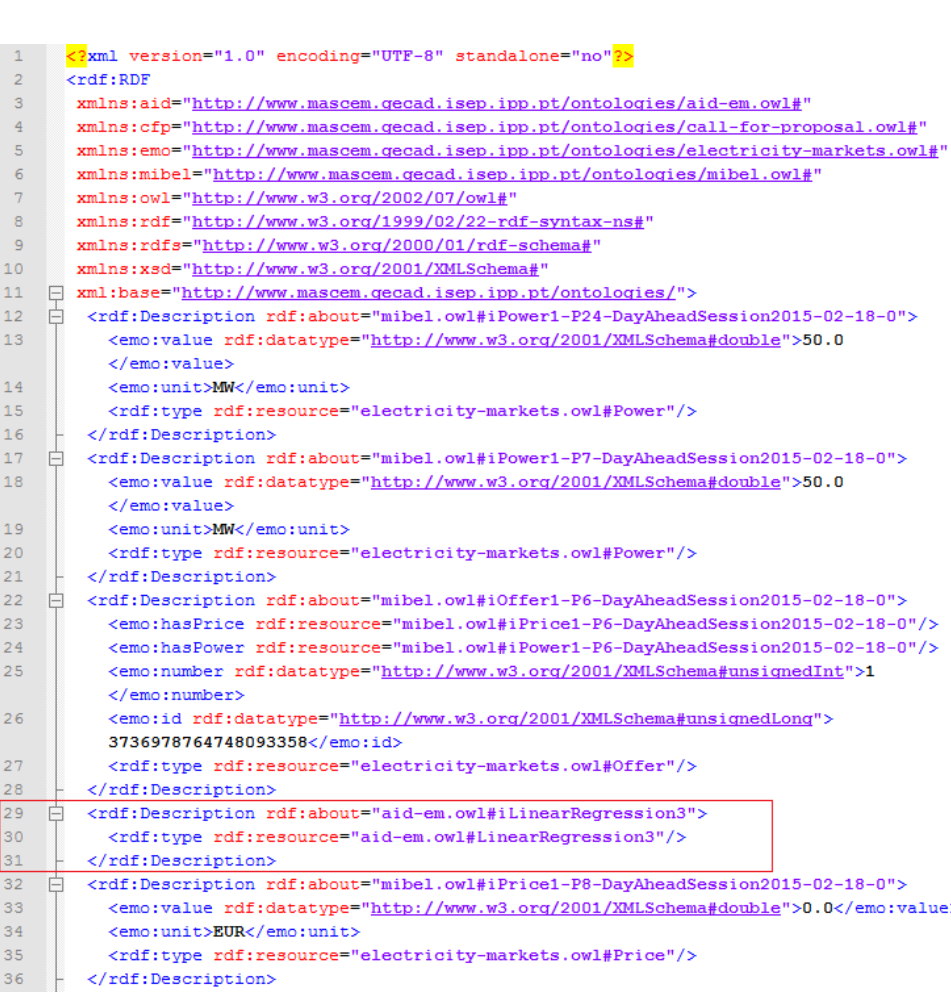
Figure 8. Player 56’s strategies